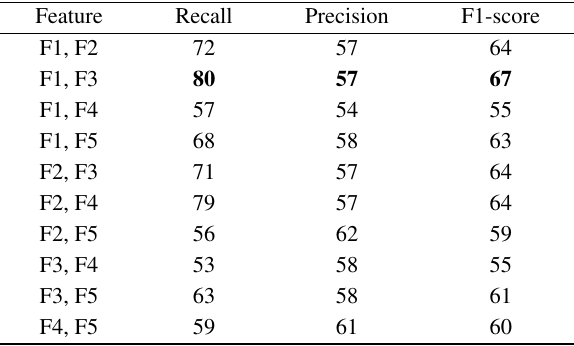
Table 4 Comparison of two different combinations of features for Radial Basis Function (RBF)